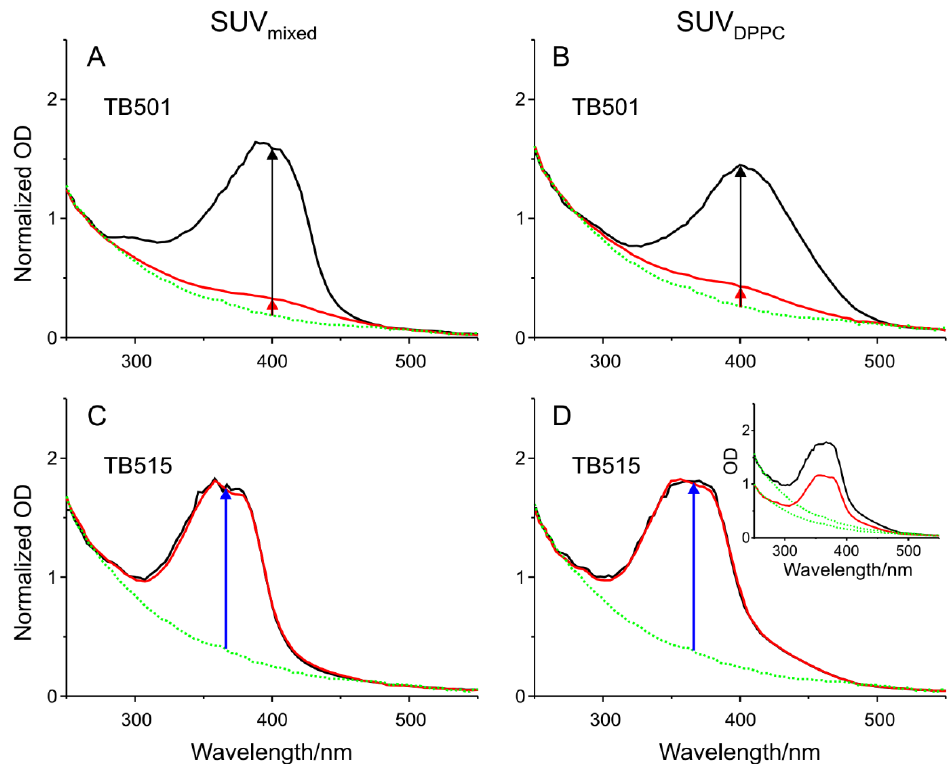
Figure 3. ( A – D ) Determination of encapsulation efficiency (EE). Absorption spectra of the encapsulated antitubercular agent candidates (TB501 and TB515) in the two different SUV formulation (SUV mixed and SUV DPPC ), represented with normalized (optical density (OD) before (black curves) and after (red curves) size exclusion chromatography (SEC). Green curves show the signal of the scattered light of liposomes themselves. These curves were used to calibrate the normalization of OD. The inset in part D shows the original spectra without normalization.